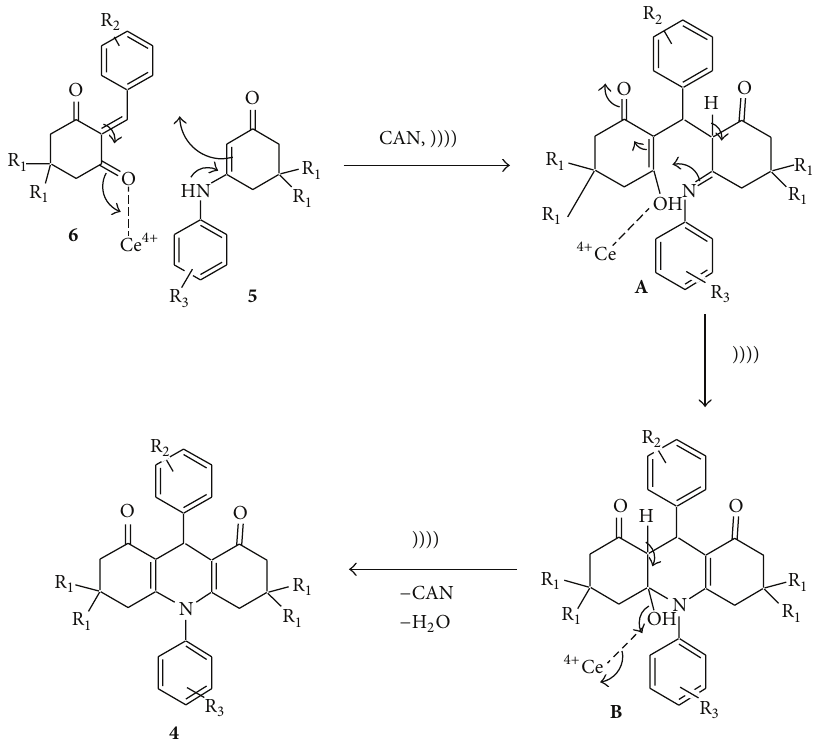
Scheme 6: A plausible mechanism for the formation of acridines from 5 and 6